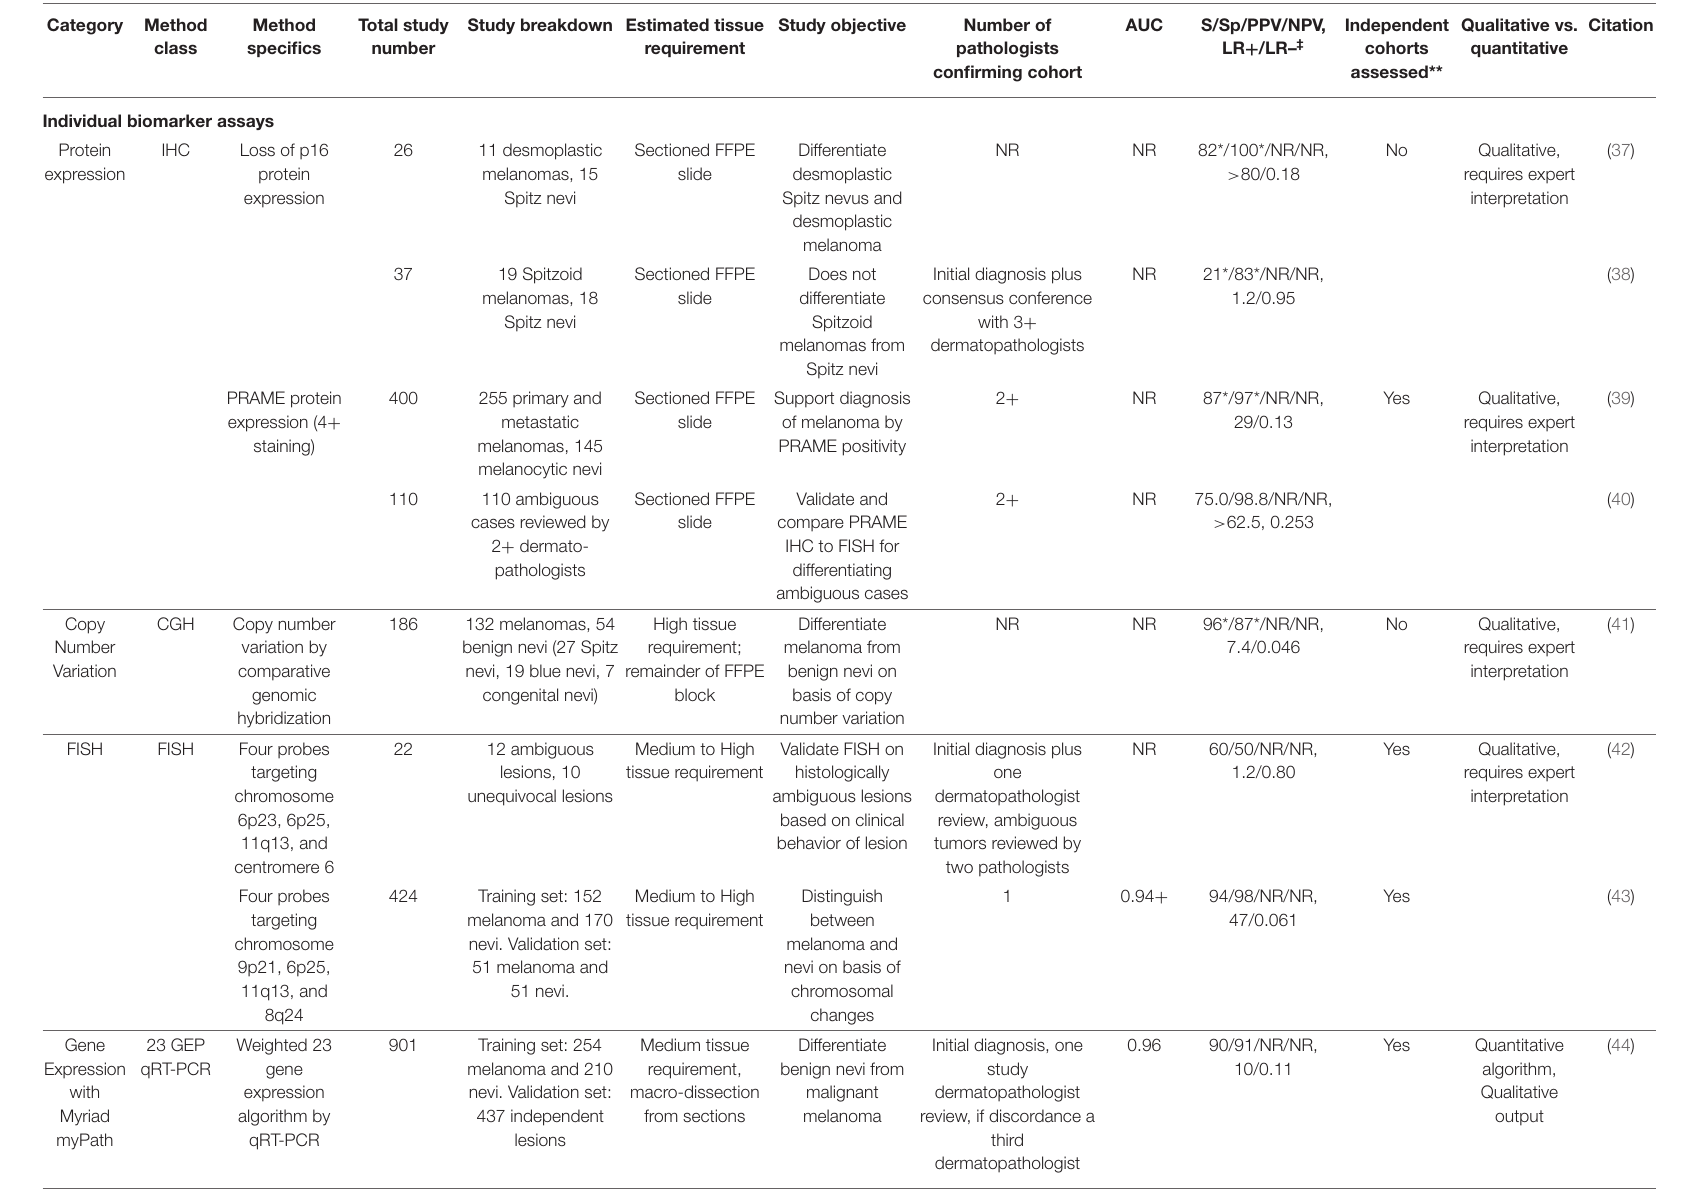
TABLE 2 | Melanoma biomarkers used by reference centers and